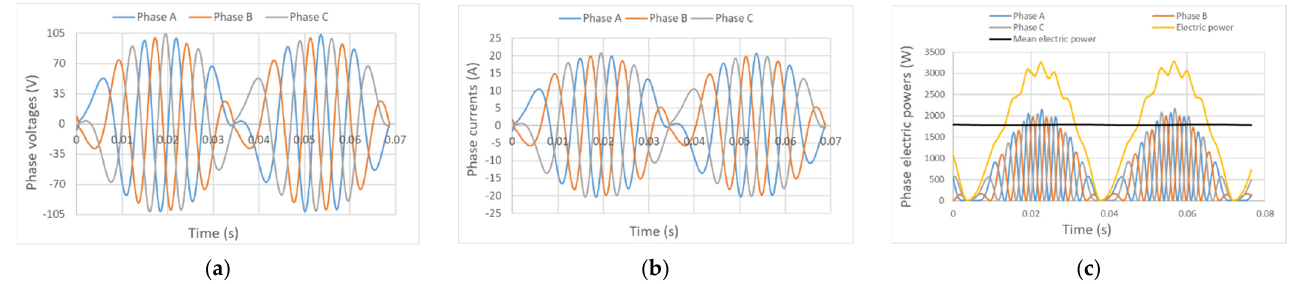
Figure 12. One mechanical cycle variation of ( a ) Phase voltages; ( b ) Phase currents; and ( c ) Electrical power dumped by the load of 5 Ohms in generator Model ‘A’.